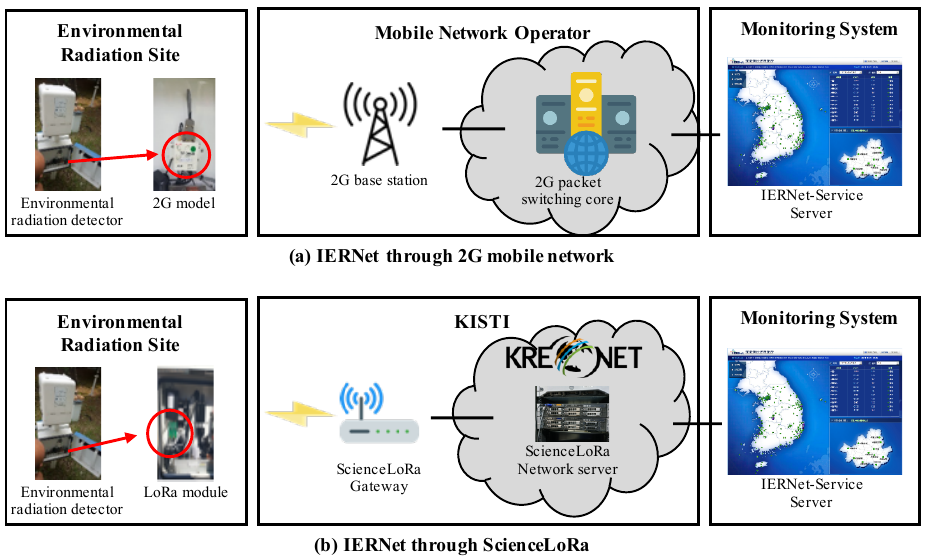
Figure 11. IERNet network architecture through ( a ) 2G mobile network and ( b ) ScienceLoRa.